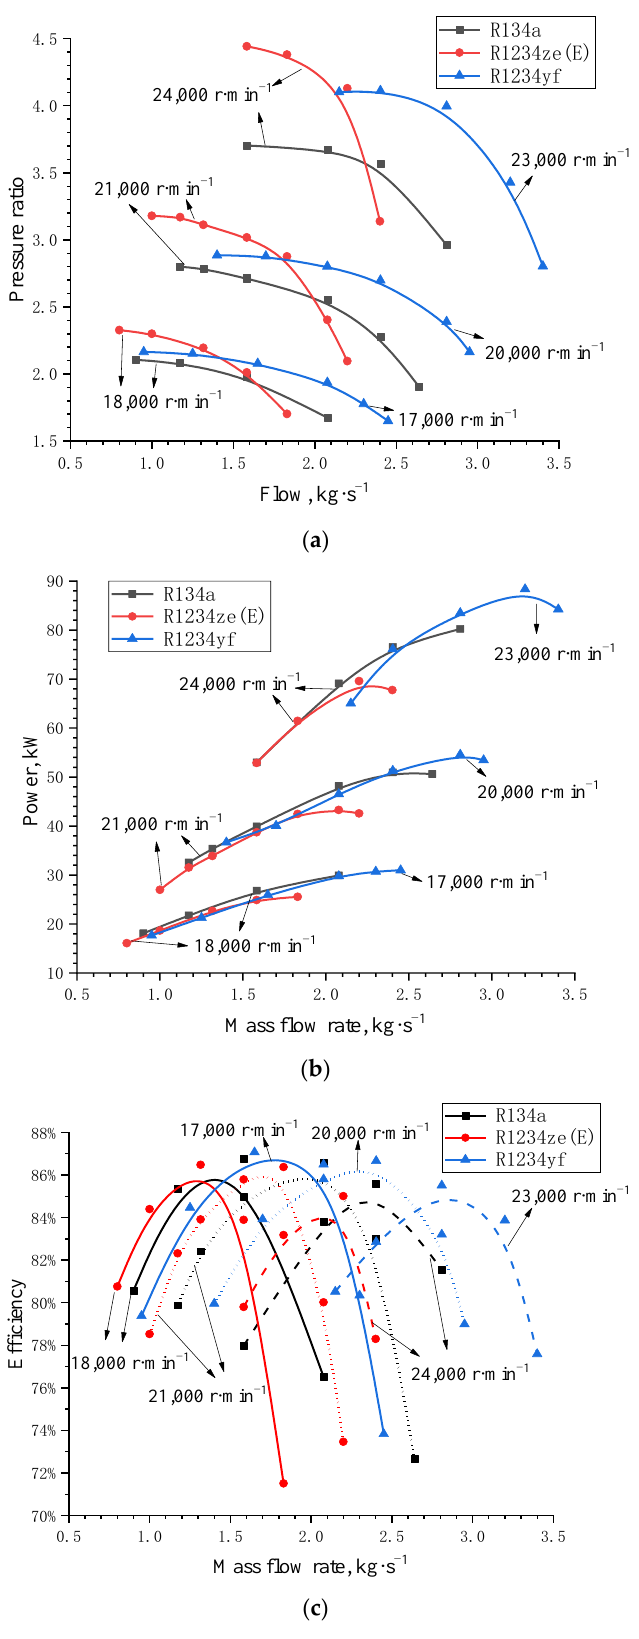
Figure 9. Performance curve of centrifugal compressor: ( a ) Mass flow rate-pressure ratio performance curve; ( b ) Mass flow rate-power performance curve; ( c ) Mass flow rate-efficiency performance